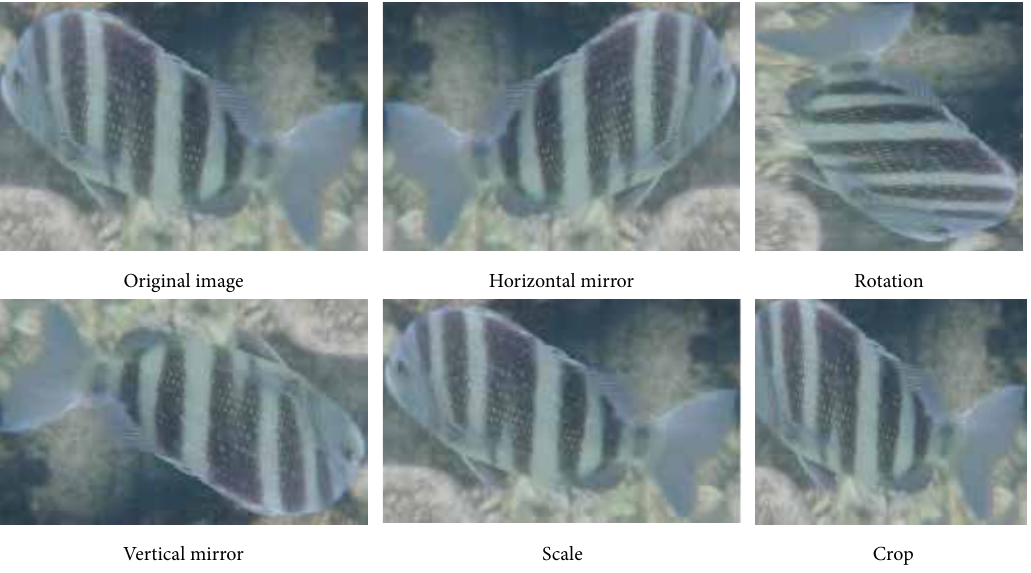
Figure 12: Data augmentation transformation.